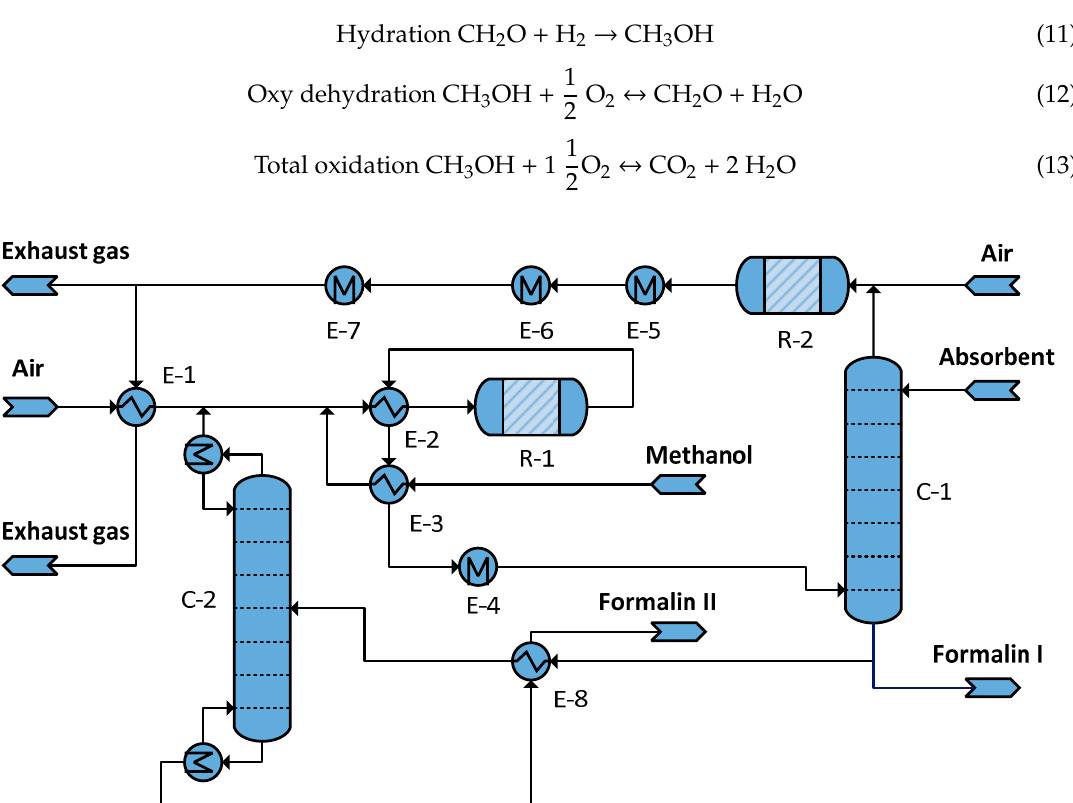
Figure 10. Process flowsheet for formalin synthesis from methanol.